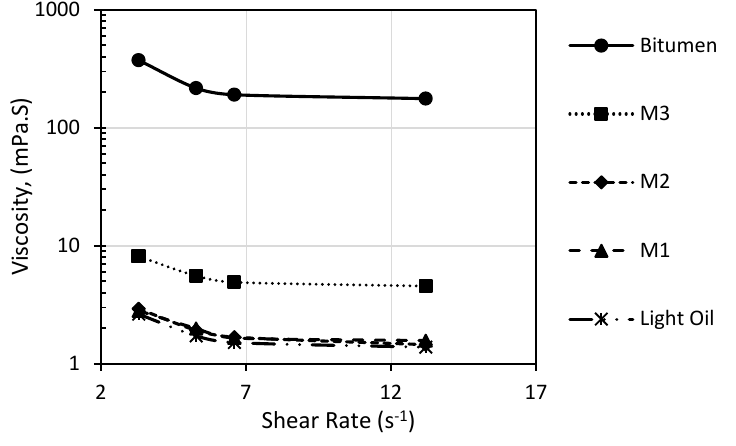
Figure 3. Rheology of the crude oils [11].